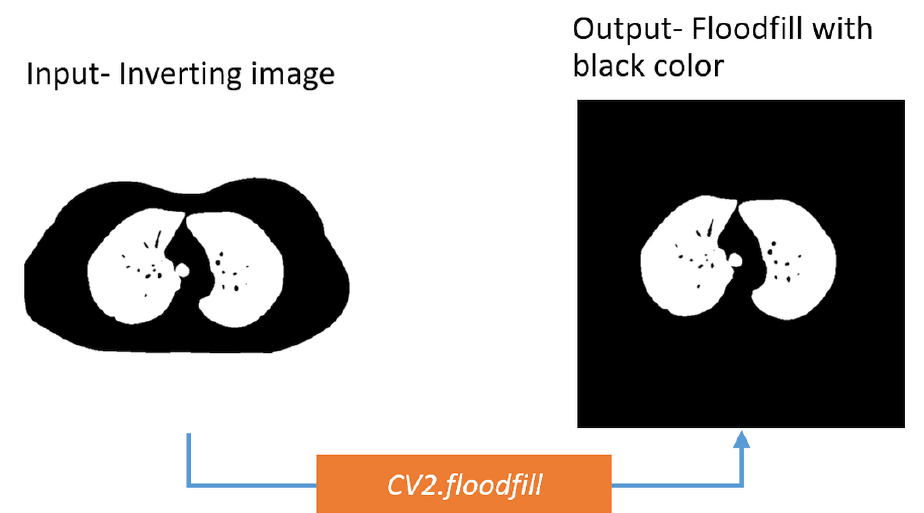
Figure 15. Making a binary mask containing the lung area using floodfill algorithm.